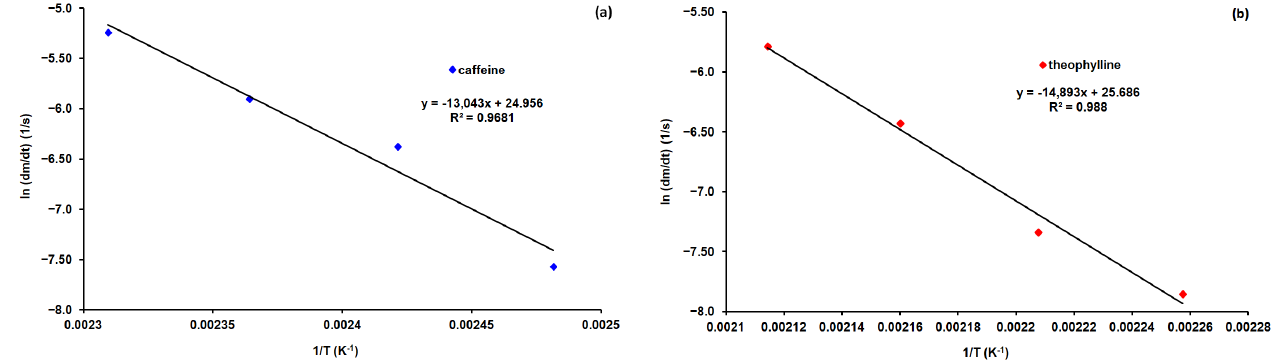
Figure 5. The variation of the sublimation rate depending on the temperature for caffeine ( a ) and theophylline ( b ).